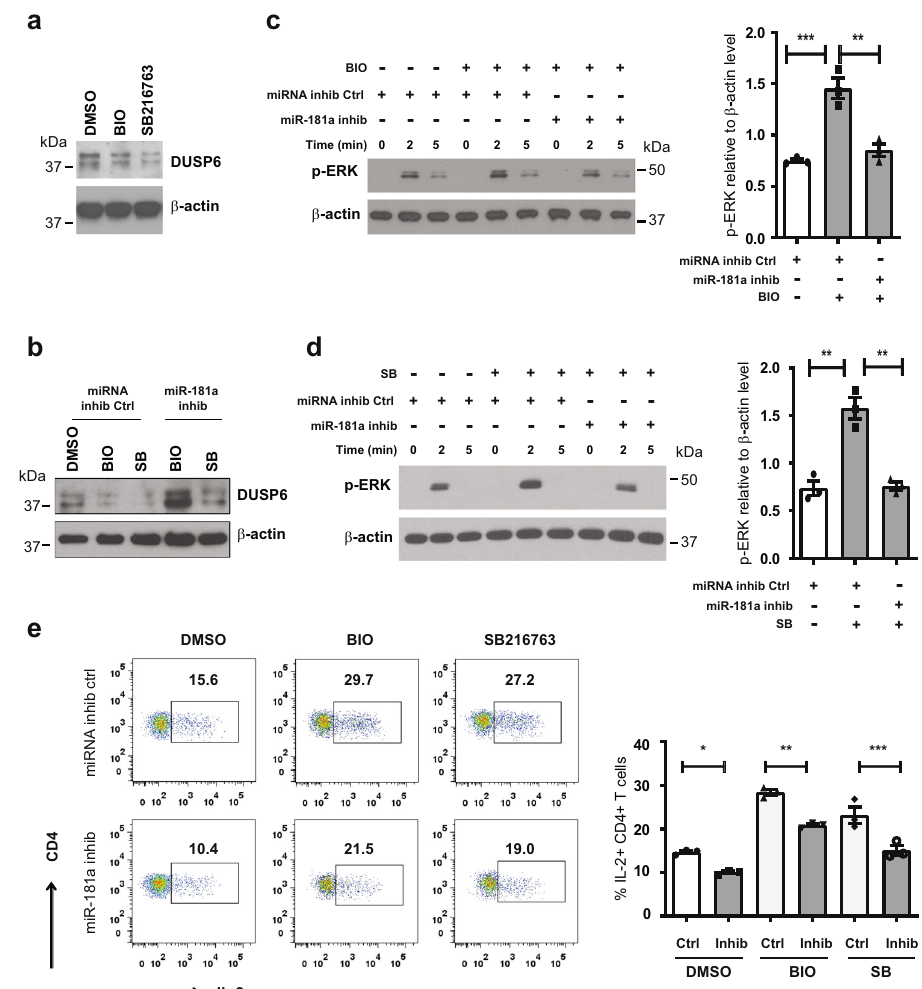
Fig. 4 GSK3 β inhibitors regulate T cell receptor signaling and T cell activation through controlling miR-181a expression. a Naive CD4 T cells were treated with GSK3 β inhibitors BIO (1 µM) or SB 216763 (5 µM) for 48 h. Cell lysates were subjected to Western blotting for the miR- 181a target DUSP6. β -actin was used as loading control. Data are representative of two experiments. b Naive CD4 T cells were transfected with miR-181a inhibitor or miRNA inhibitor negative control and then cultured and analyzed for the expression of DUSP6 after culture with GSK3ß inhibitors as described in ( a ). Data are representative of two experiments. c , d Naive CD4 T cells, transfected with miR-181a inhibitor or miRNA inhibitor negative control, were treated with GSK3 β inhibitors BIO (c, 1 µM) or SB 216763 (d, 5 µM) as described above. Immunoblots of pERK signals (Thr202/Tyr204) at indicated times after CD3/CD28 cross-linking (left) and mean±SEM of pERK relative to β -actin levels at 2 min ( n = 3, right) are shown. Uncropped Western blots in Supplementary Fig. 4. All samples in a blot derive from the same experiment and were processed in parallel. e Naive CD4 T cells, transfected with miR-181a inhibitor or miRNA inhibitor negative control, were pre-treated with DMSO, 1 µM BIO, or 5 µM SB216763 as described above. Intracellular cytokine staining for IL-2 is shown as representative scatter plots (left) and mean frequencies±SEM of IL-2-producing cells of three experiments (right). Comparisons were done by one-way ANOVA with post-hoc Tukey test. Signi fi cance levels are indicated as * P < 0.05, ** P < 0.005, *** P <